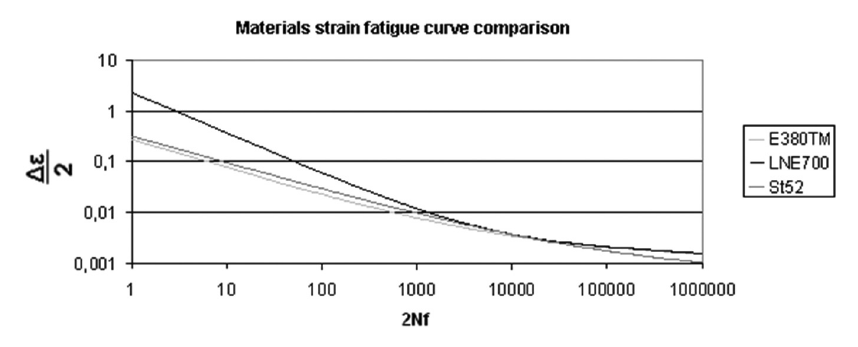
Figure 5. Designs materials Strain-Life Fatigue